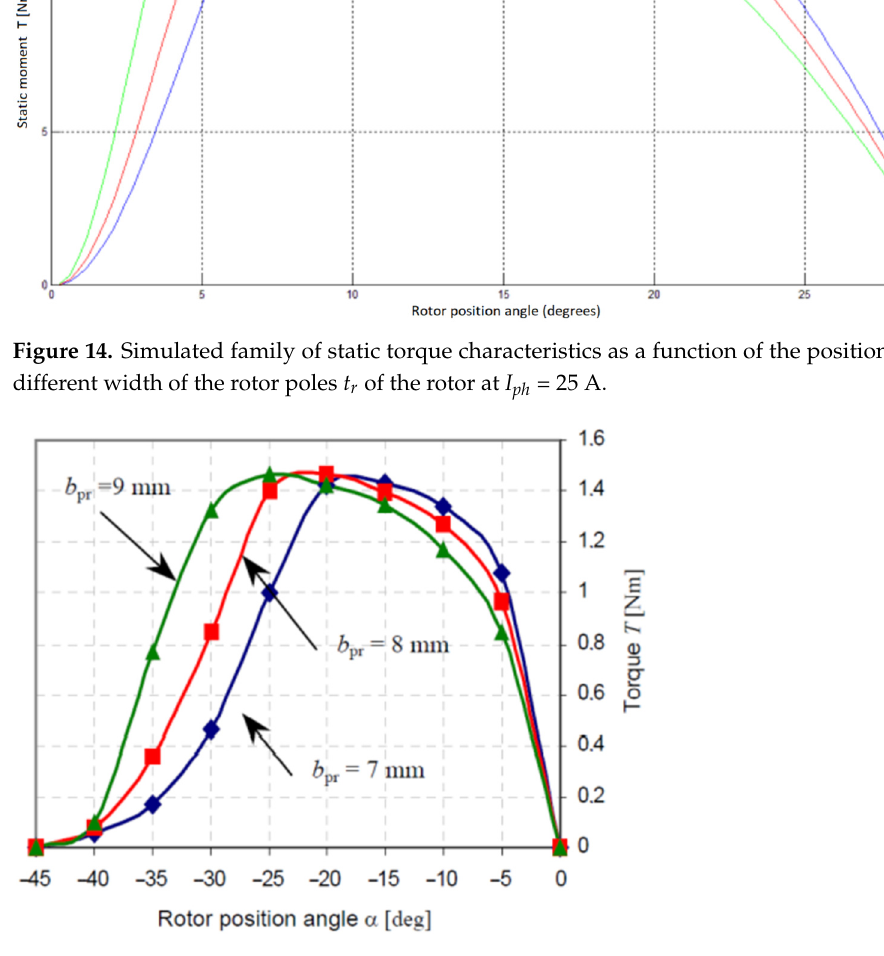
Figure 15. Family of static torque characteristics as a function of the angle of the rotor position and the width of the poles of the rotor at I ph = const .